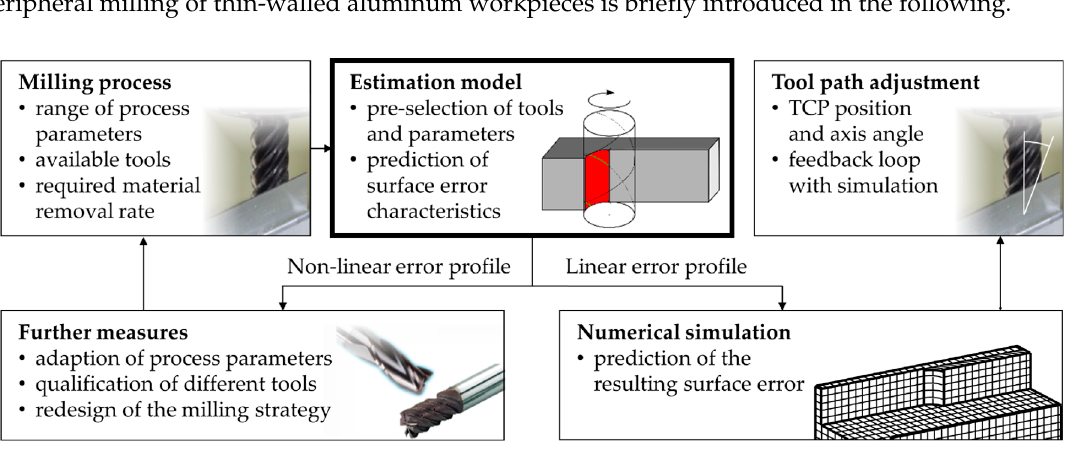
Figure 1. General approach for error compensation and the use of the estimation model; TCP: tool center point.